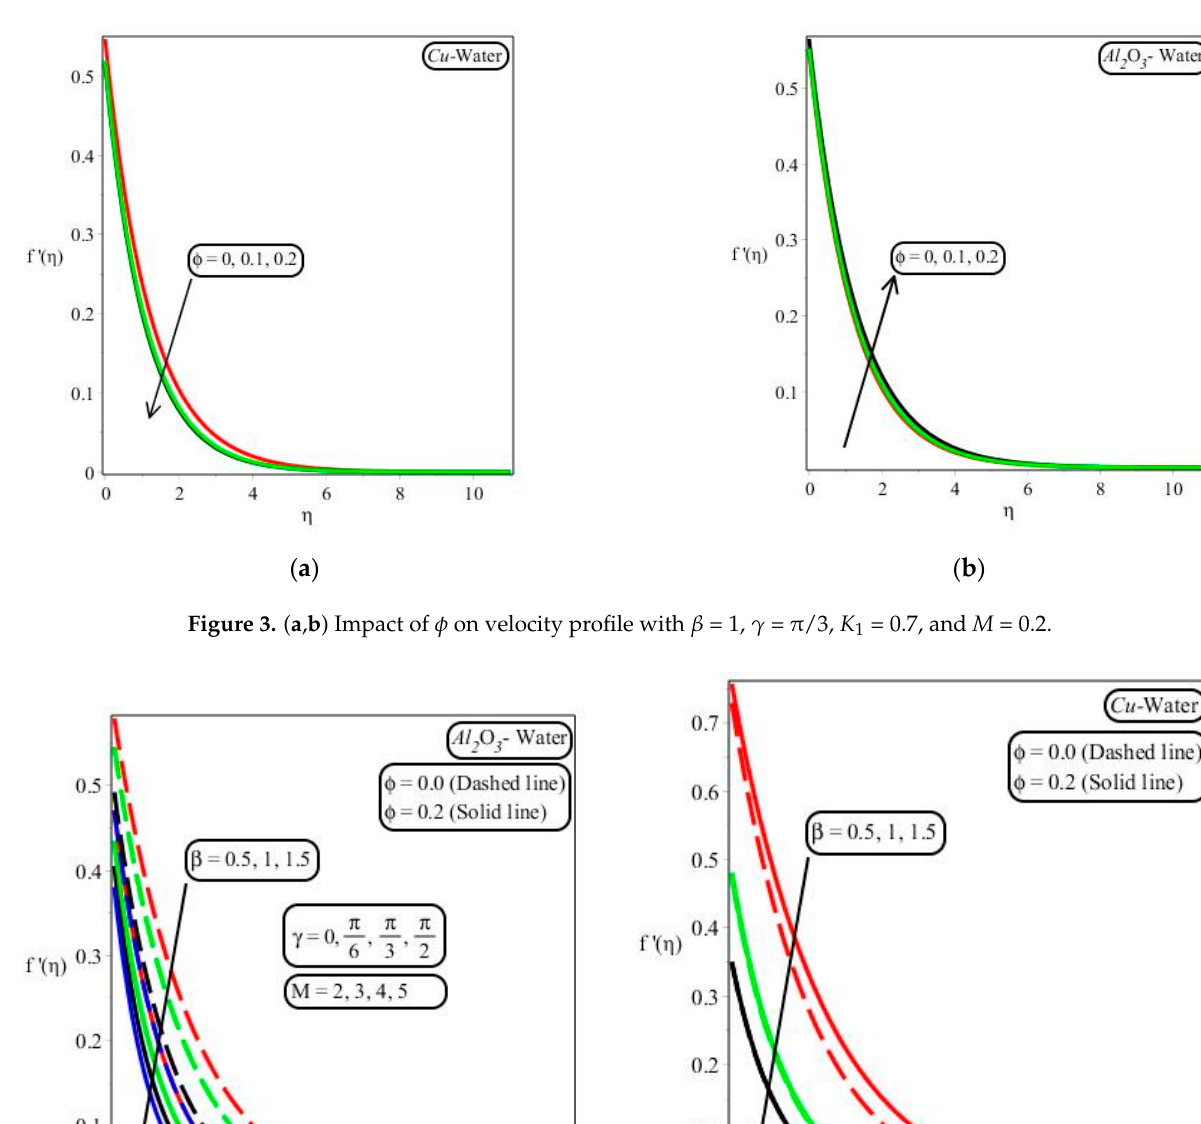
( b ) Figure 5. ( a , b ) Impact of K 1 on temperature profile with β = 0.7, γ = 𝜋/4 , and φ = 0.2.